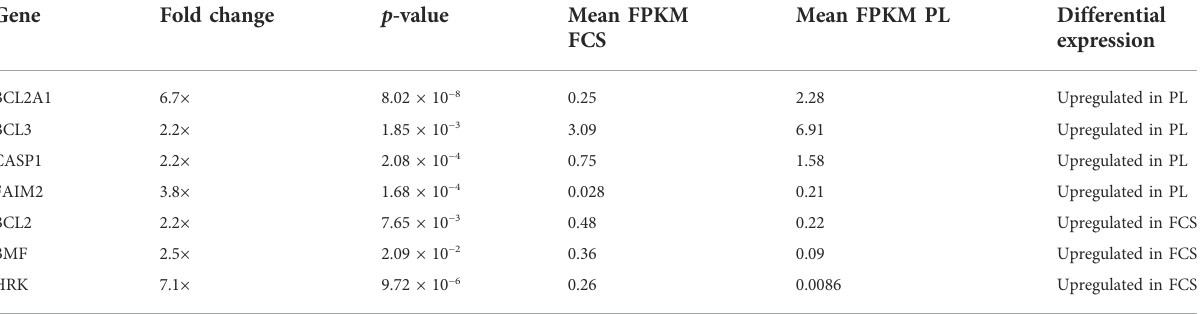
TABLE2DifferentialexpressionofgenesinvolvedinapoptosisinMSCsexpandedinFCSandPLsupplementedmedium.Genesaredesignatedbytheir gene name and expression data were fi ltered based on fold change (at least twofold) and p -value ≤ 0.05. To provide additional information on